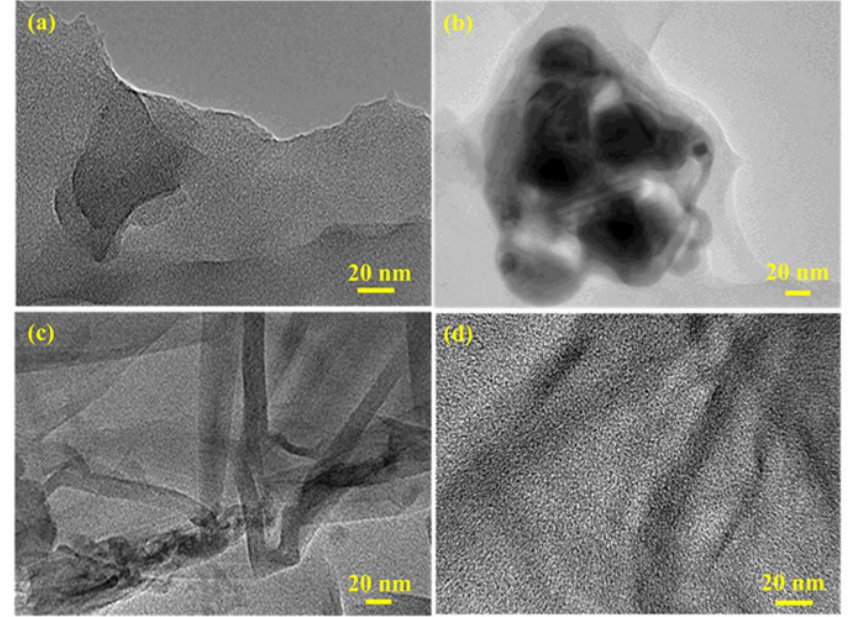
Figure 5. The HR-TEM micrographs of ( a ) neat PSTY; ( b ) GO-PSTY; ( c ) RGO-PSTY and ( d ) R-(GO-PSTY)